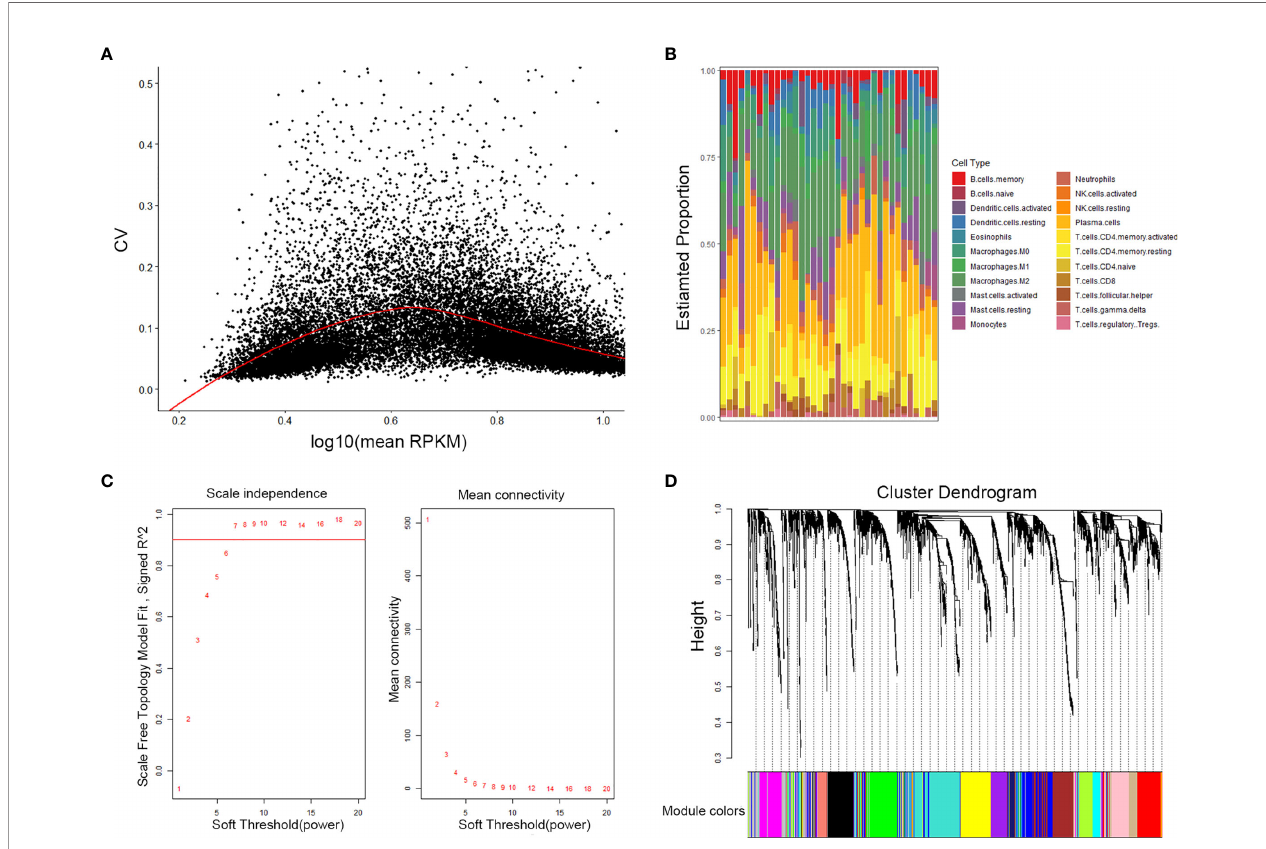
FIGURE 2 | Selection of the appropriate beta value to construct a hierarchical cluster number. (A) Selected genes with Coef fi cient of variation values greater than 0.15. (B) Estimate fraction of immune cells by CIBERSORT algorithm in GSE16515. (C) Analysis of the scale-free fi t index and of the average connectivity of 1 – 20 soft threshold power. (D) Genes are grouped into diverse modules by hierarchical clustering. Different colors represent different